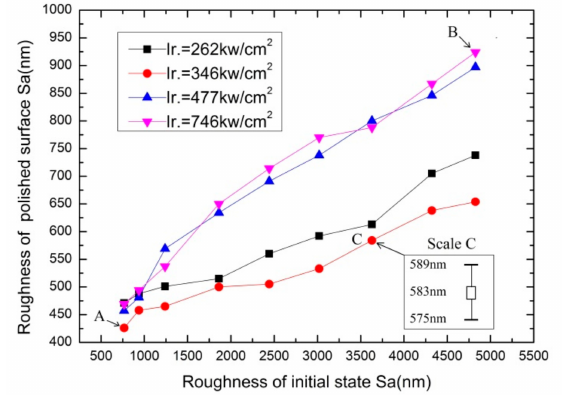
Figure 3. Polished roughness related to initial roughness.